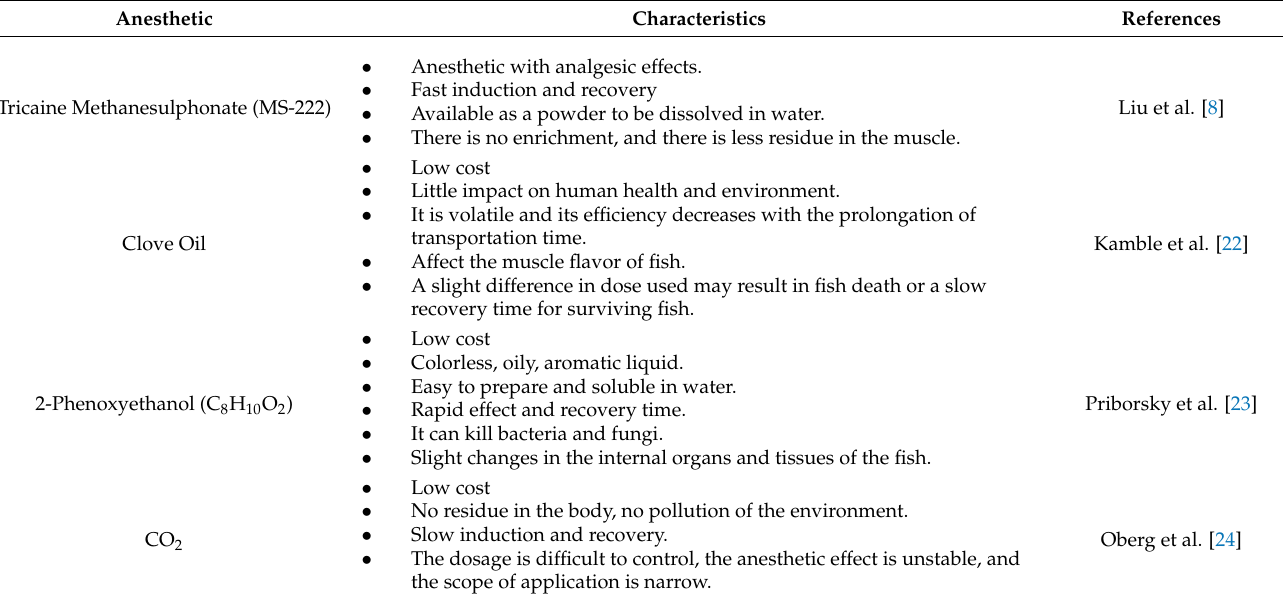
Table 1. Several anesthetics commonly used in fish and their